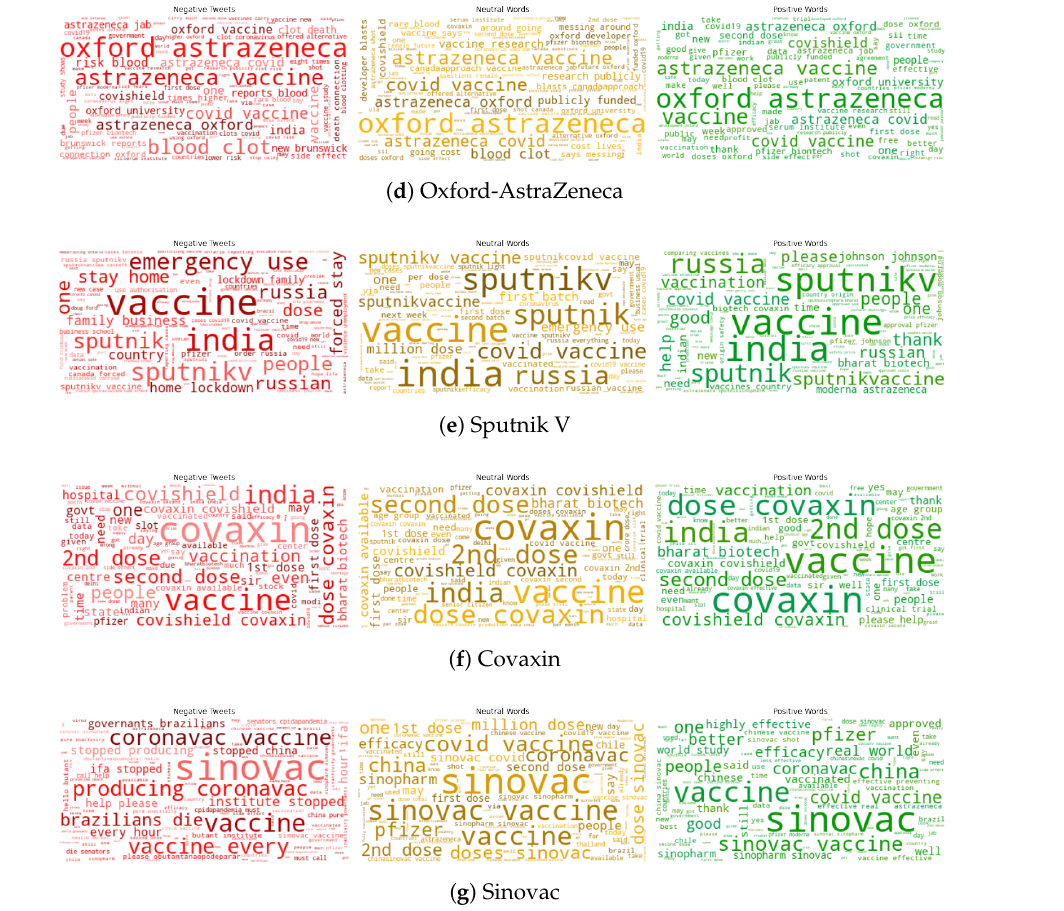
Figure A3. Top frequency word distribution for different vaccines: word cloud generated using word frequencies.